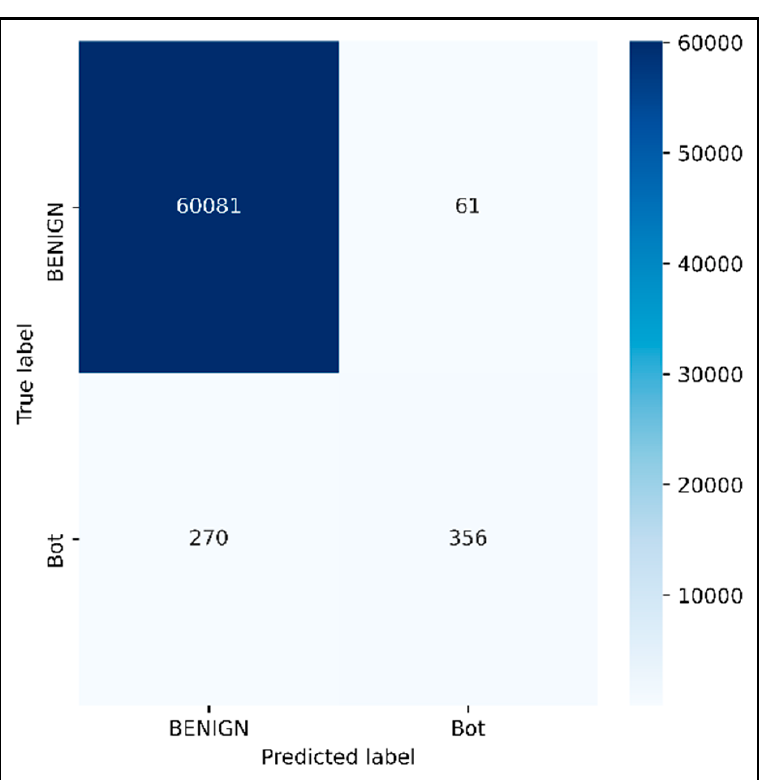
Figure 12. Friday morning confusion matrix.